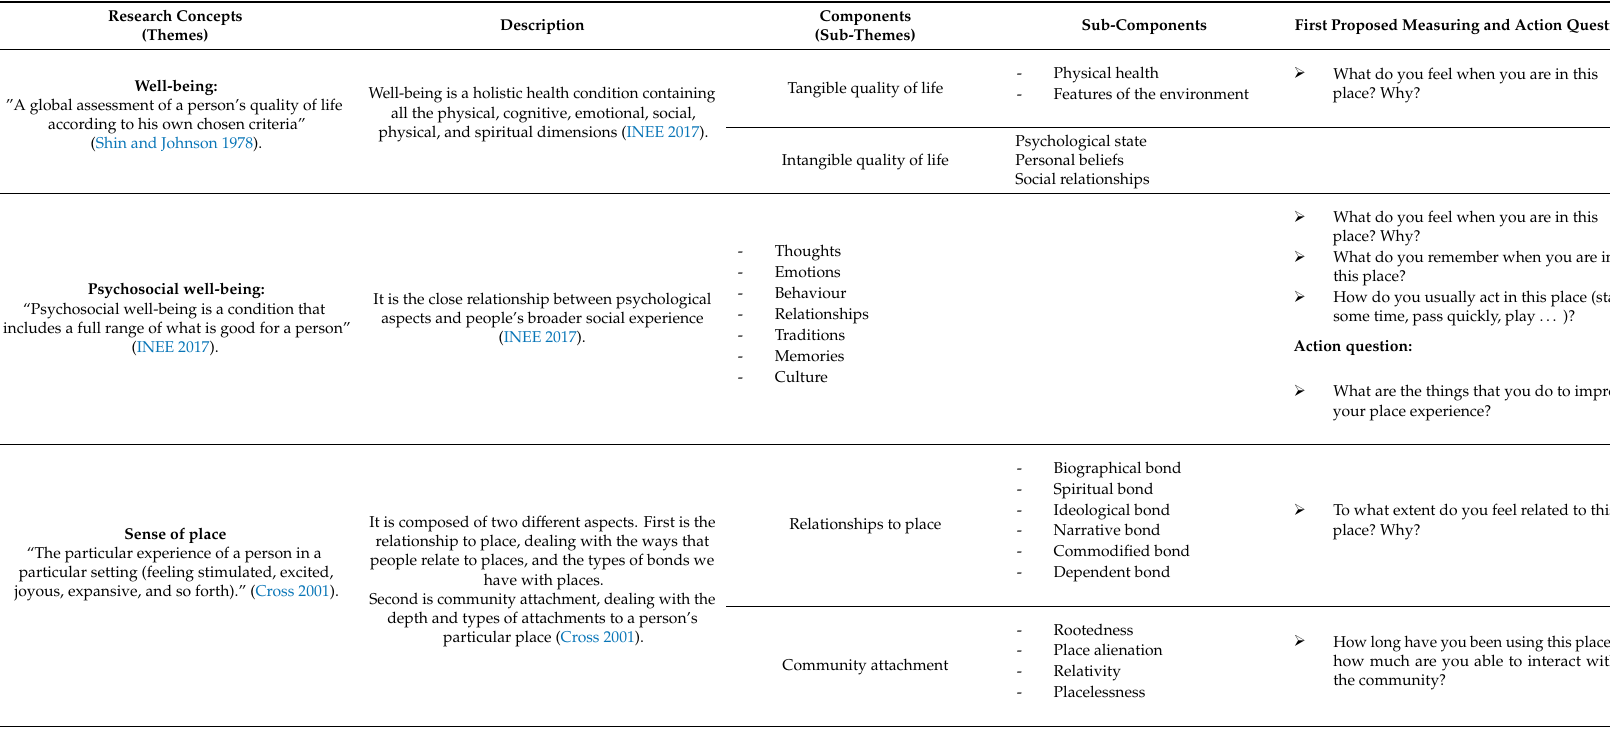
Table A1. This table shows the process of designing the interview questions. The research concepts / themes were extracted from the literature review phase and were broken to sub-themes (descriptions, components, and sub-components) in order to be covered by the interview